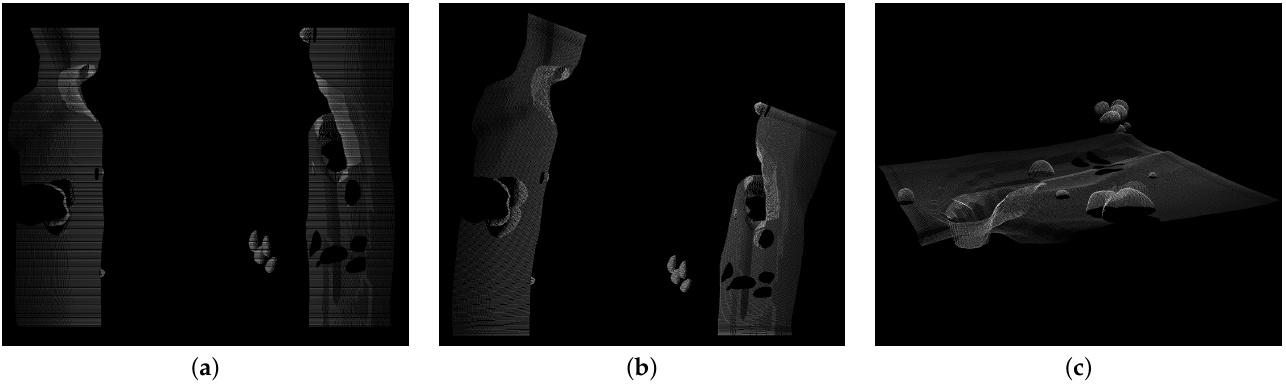
Figure 15. Display and export options for distance-measurement data of virtual Sonar sensors. ( a ) The left image corresponds to the classic side view Sonar. ( b ) For the middle image, the rotation of the measuring probe was taken into account for the alignment of the measurement data. ( c ) The right image shows the intensity measurement data as a 3D